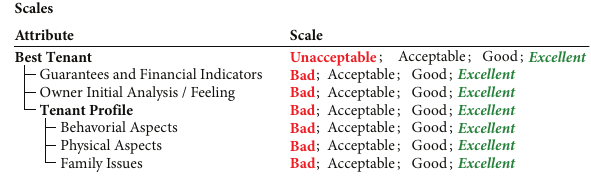
Figure 5. Evaluation scales